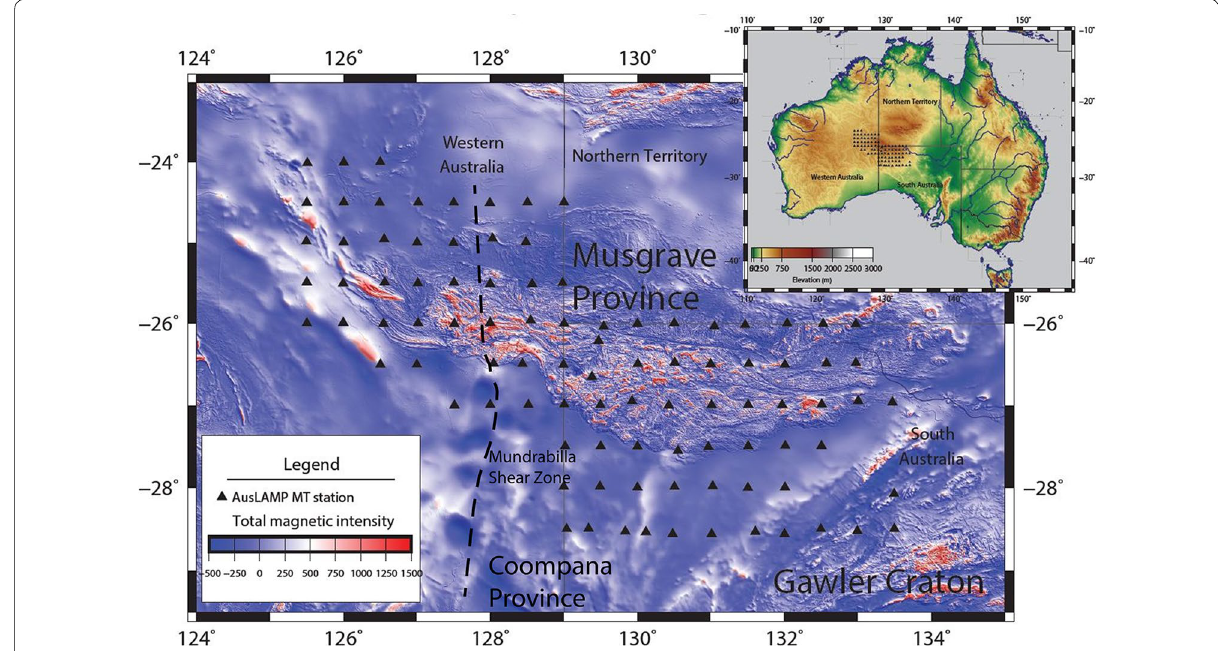
Fig. 3 Map of the central Australian region showing total magnetic intensity over the Musgrave Province with the location of the Musgrave Province MT sites superimposed as black triangles. Inset is Australian relief image with MT sites superimposed to show geographic coverage with respect to the Australia continent. The Mundrabilla Shear Zone is shown as a dashed line (Aitken et al.